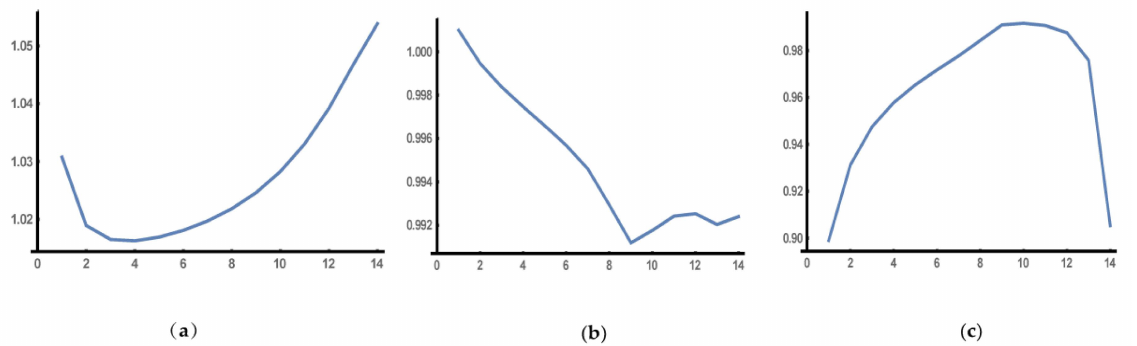
Figure 10. The graph of ( a ) the largest real eigenvalue; ( b ) the modulus of the complex conjugate eigenvalues; ( c ) the smallest real eigenvalue versus k